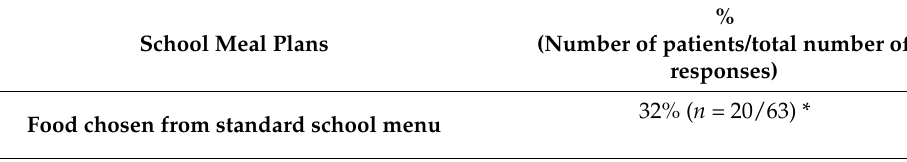
Table 3. Meal provision within school and type of special low protein foods